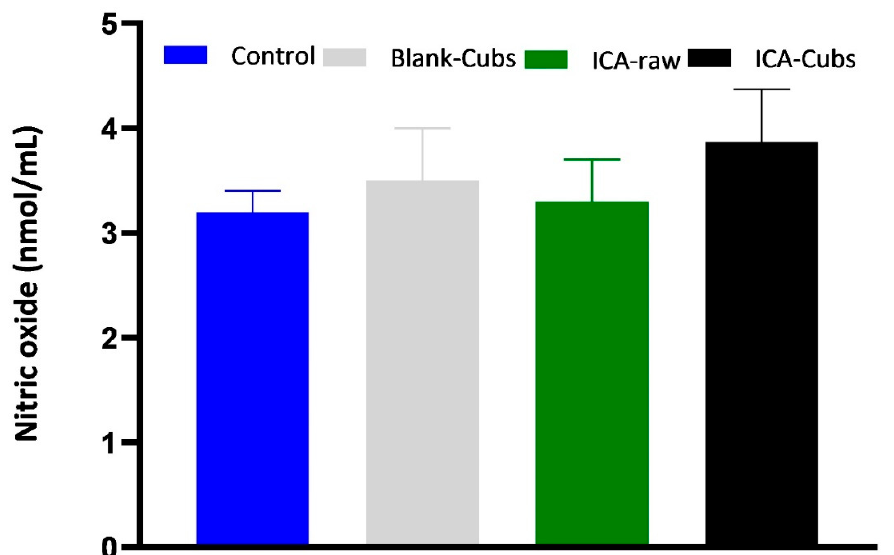
Figure 13. Generation of NO in SKOV-3 cells following treatment with blank-Cubs, ICA-raw, and ICA-Cubs. Data are expressed as the mean ± SD (n = 4 runs).